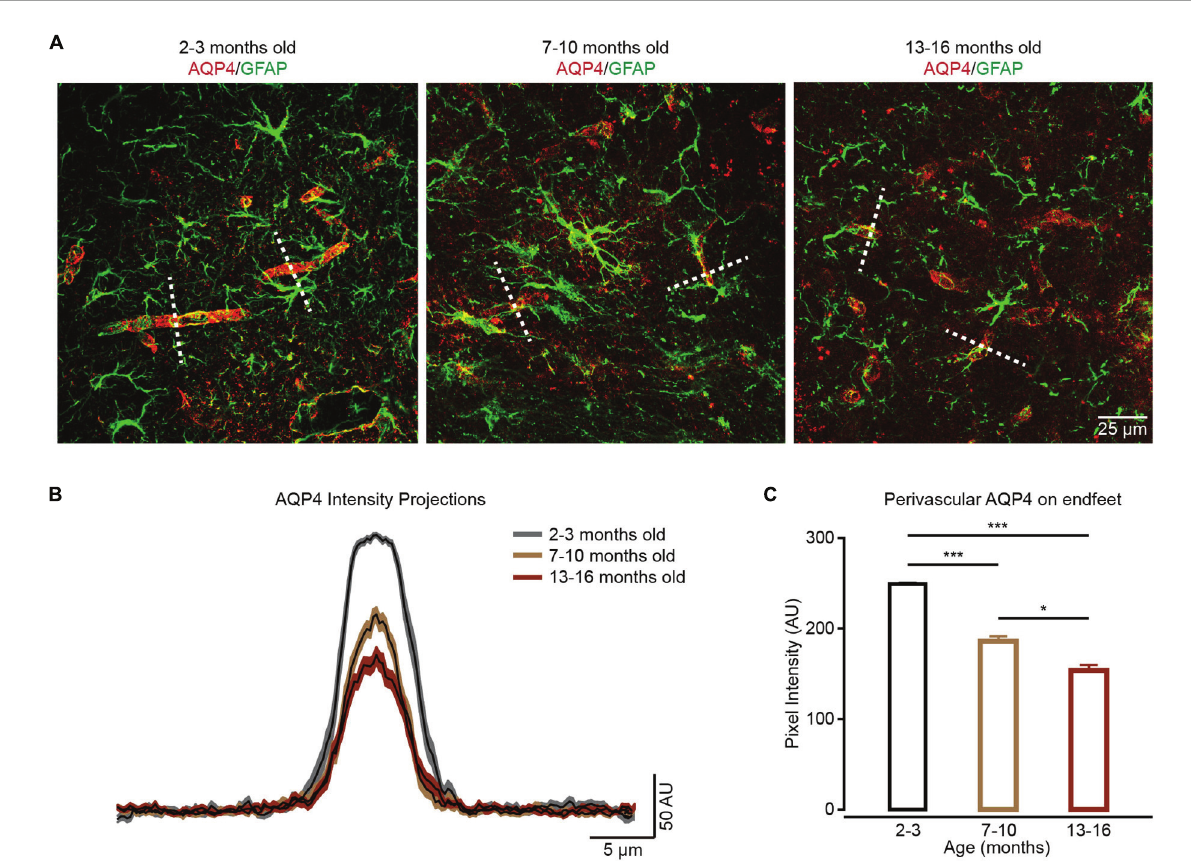
FIGURE4 The localization of perivascular AQP4 on endfeet is lost during brain aging. (A) In contrast to the well-maintained localization of perivascular AQP4 (red) on endfeet (perivascular GFAP labeled green structure) in the 2–3-month-old group (left panel), perivascular AQP4 localization becomes more dispersed in the 7–10-month-old and 13–16-month-old groups (middle and right panel). (B) AQP4 immunofluorescence was evaluated in linear regions of interest (dashed lines, A ) extending outward from vessels. (C) Bar graph summarizing measurement of perivascular AQP4 expression on endfeet. Compared with the 2–3-month-old group ( n = 47 vessels from four mice), perivascular AQP4 expression on endfeet decreased in the 7–10-month-old group ( n = 40 vessels from four mice) and 13–16-month-old group ( n = 45 vessels from four mice); the 2–3-month-old group versus 7–10-month-old group: P = 6.67 × 10 - 10 ; the 2–3-month-old group versus the 13–16-month-old group: P = 4.1959 × 10 - 20 ; the 7–10-month-old group versus the 13–16-month-old group: P = 0.0359, * P < 0.05, *** P < 0.001, Kruskal–Wallis test followed by Dunn’s multiple comparisons test. All data are shown as the mean ±